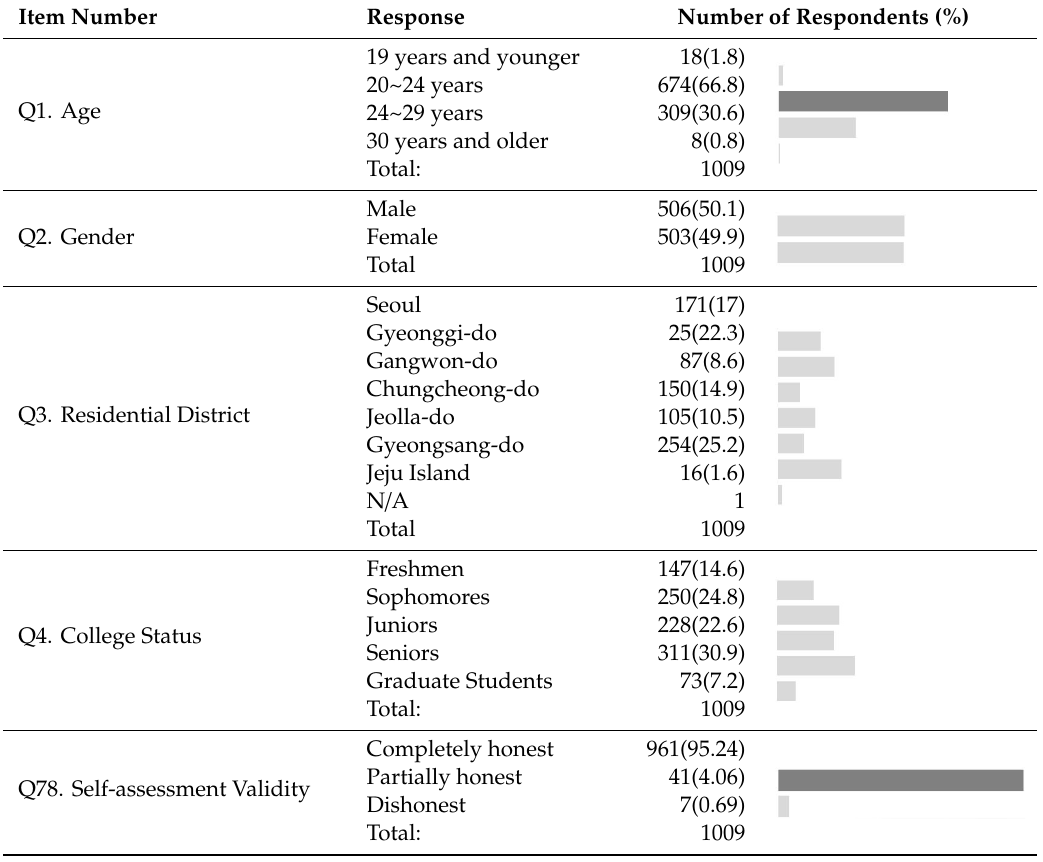
Table 1. Demographic statistical information of survey